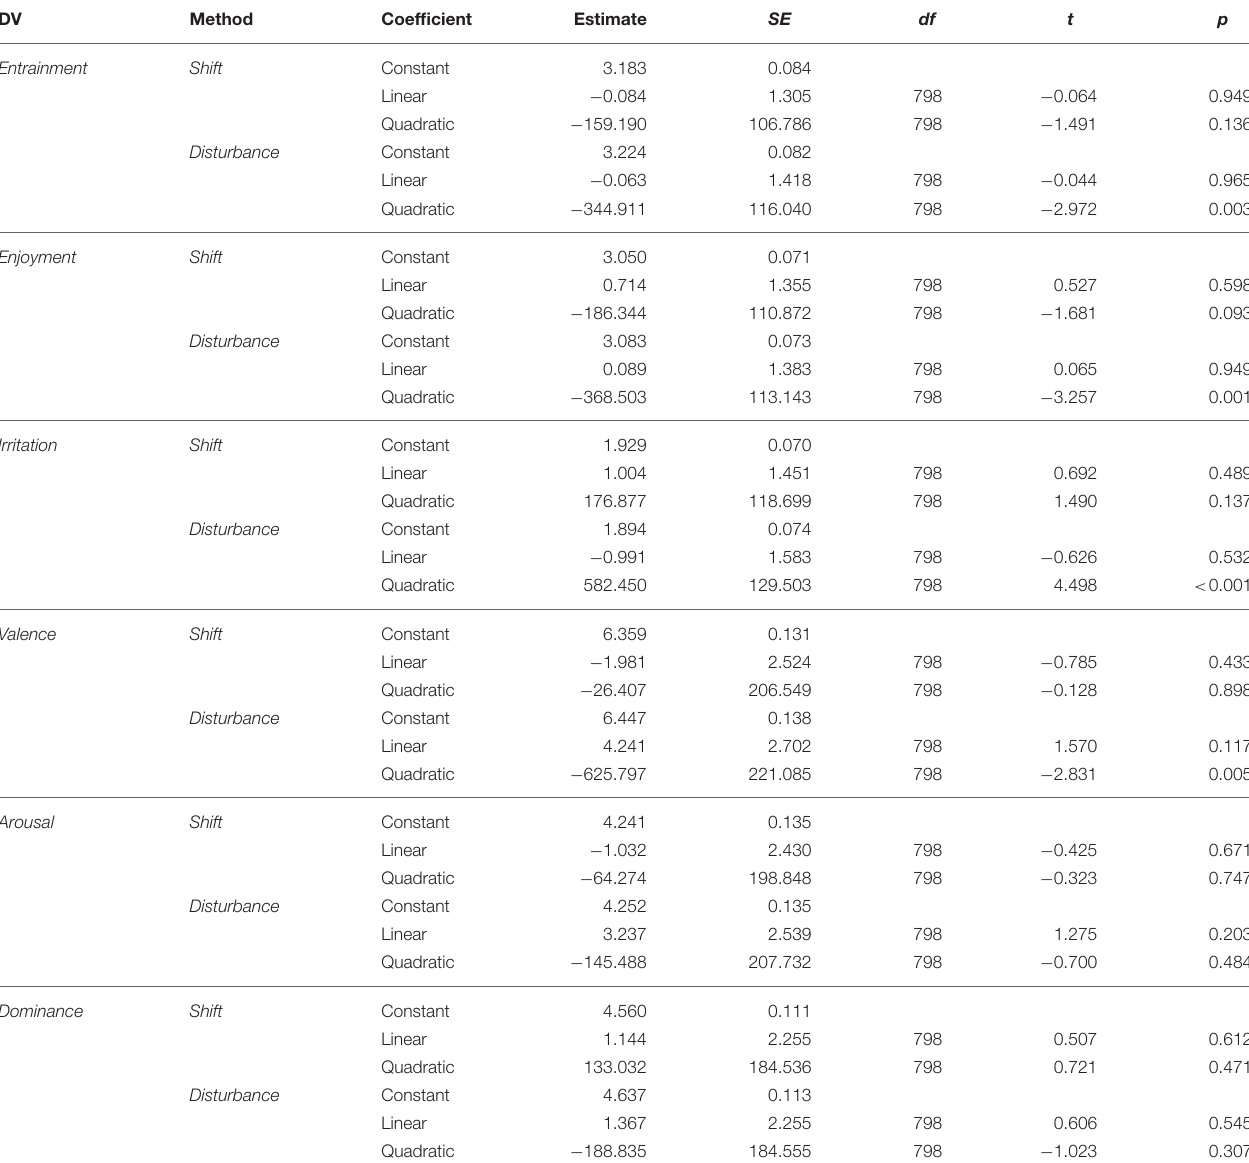
TABLE 1 | Study A : Regression models for the relationships between Displacement Magnitude and the EAG and SAM response variables, separated by Timing Manipulation Method . DV Method Estimate t